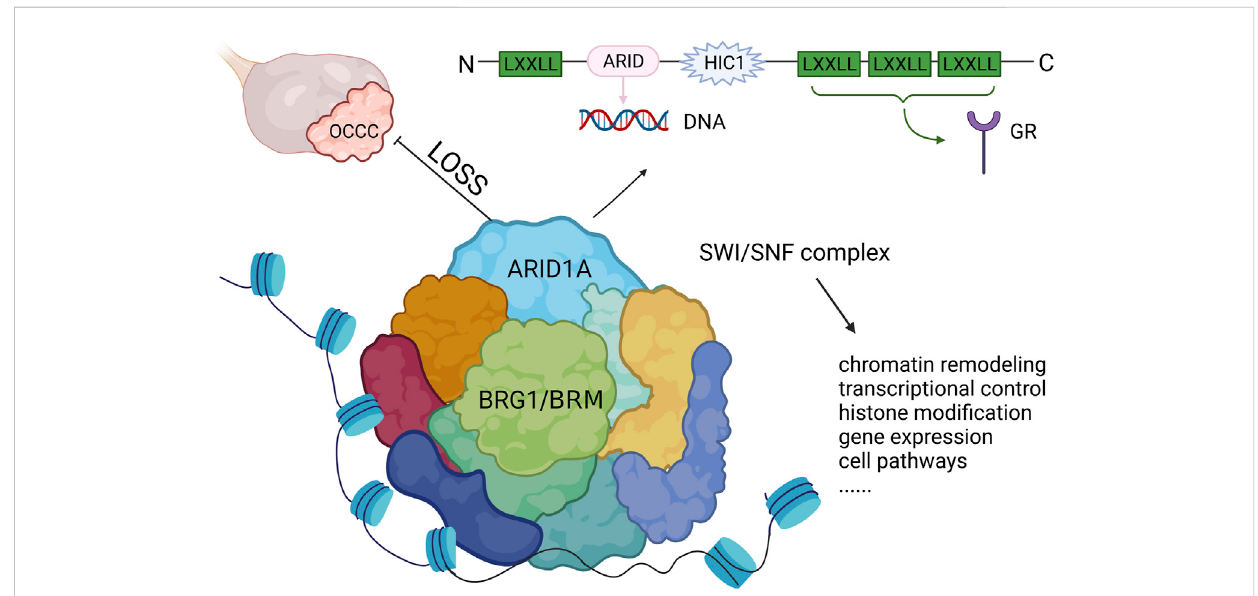
FIGURE 2 The structure of ARID1A and its role in OCCC. ARID1A mutation leads to the loss of expression and inhibits the function of SWI/SNF complex, which drives tumor malignancy. LXXLL, Leucine-x-x-leucine-leucine motif; ARID, AT-rich interactive domain; HIC1, hypermethylated in cancer 1 domain; GR, glucocorticoid